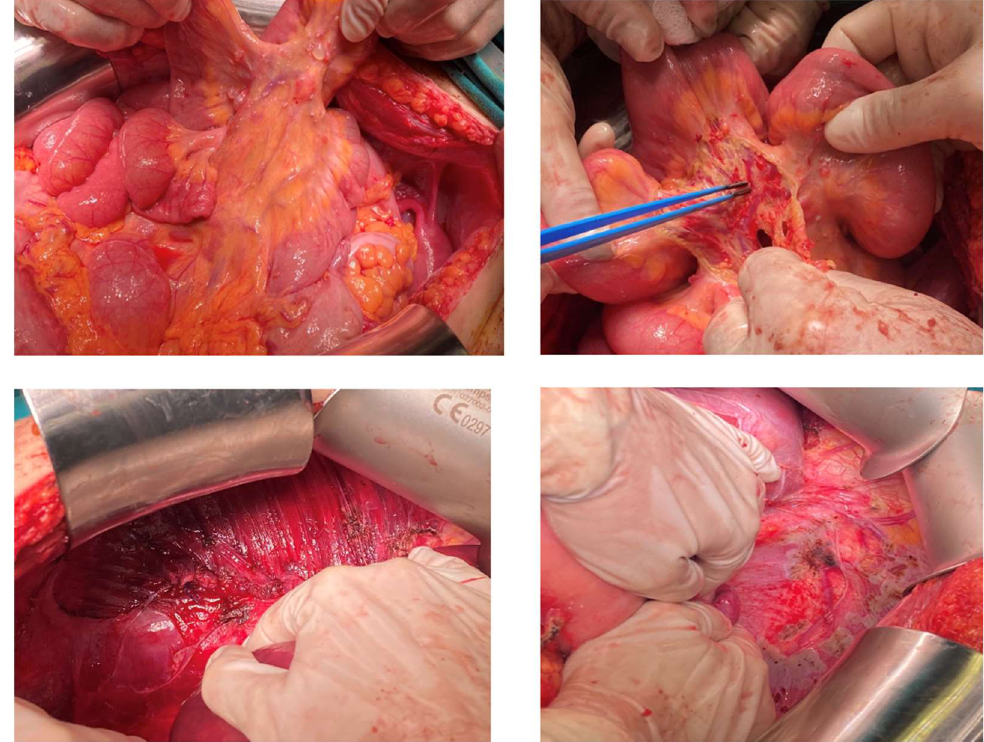
Figure 2. A case of a 25-year-old diagnosed with HDFCO managed at our department. Intraperitoneal lesions extended to peritoneal surfaces, including (i) the mesentery, and (ii) the subdiaphragmatic peritoneum.